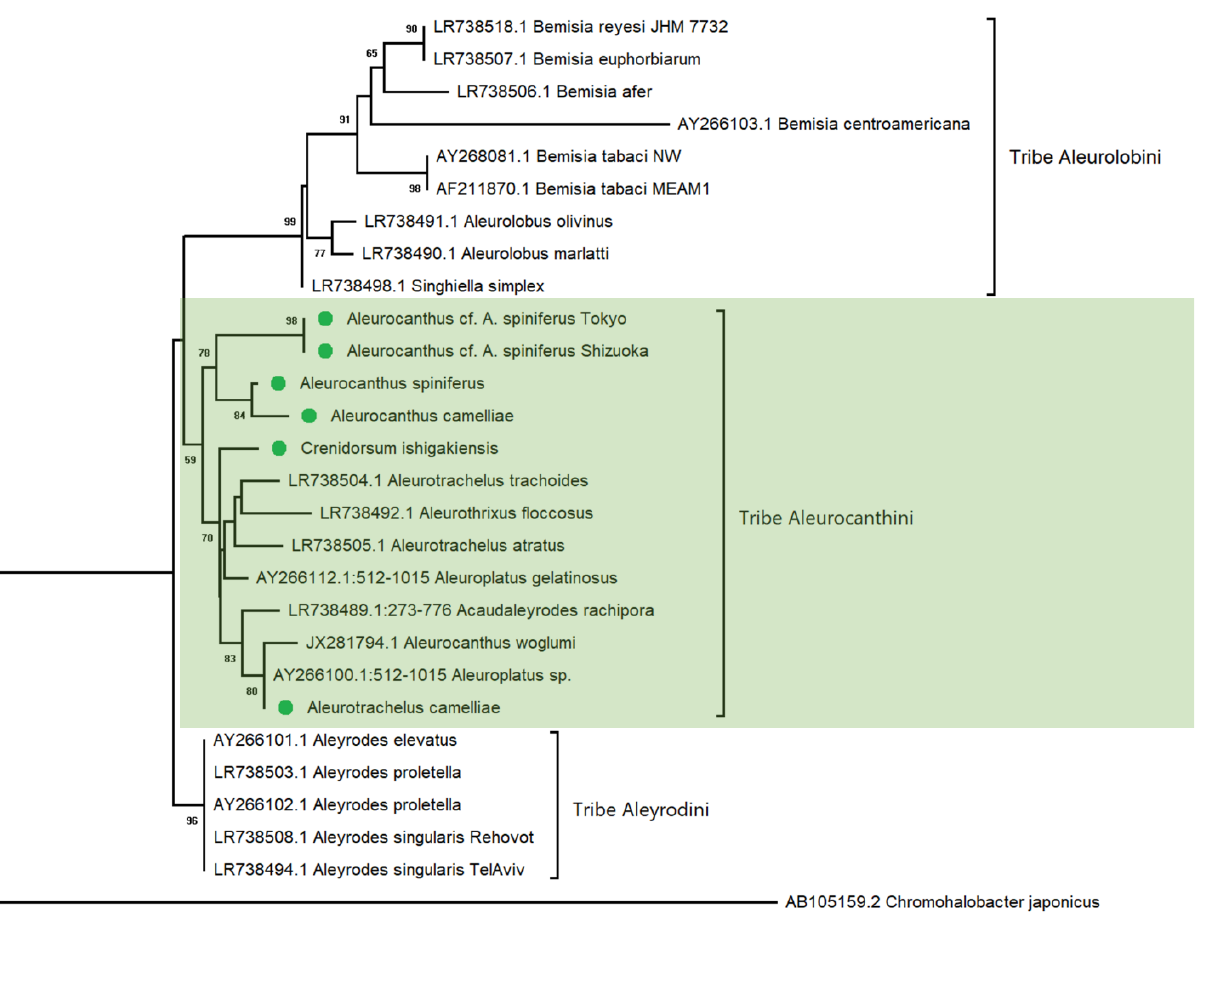
Figure 7. Portiera strain clustering of 16Sr RNA by NJ phylogenetic tree constructed using LogDet (Tamura–Kumar) method [86]. The sequence of Chromohalobacter japonicus (No. AB105159) was placed as an out-group. The green circles are the samples examined. Alignment length 504 bp. The phylogenetic tree reconstruction on these single gene analyses (Figures 6 and 7) failed to illustrate the clustering genera at least in the tribe Aleurocanthini. In the phylogenetic reconstruction of Aleurocanthus woglumi , for instance, both the mitoribosome (ID JX281761) and Portiera (ID JX281794) are consistently paraphyletic within Aleurocanthus species. The same pattern was found in the sequences Tetraleurodes mori (ID AY521262) and Tetraleurodes acaciae (ID AY521262) on the mitoribosome phylogenetic tree (Figure 6). The Portiera strains of Aleurotrachelus spp. were separated into at least three clusters (Figure 7), i.e., Crenidorsum (=Aleurotrachelus) ishigakiensis, Aleurothrixus (=Aleurotrachelus) trachoides (ID LR738504), and Aleurotrachelus camelliae . However, interestingly, all molecular typing using ITS1, the 16S of mitoribosome, and the 16SrRNA of Portiera reconstructed the close association of A. spiniferus to A. camelliae instead of Aleurocanthus cf. A. spiniferus (Figures 3, 6 and